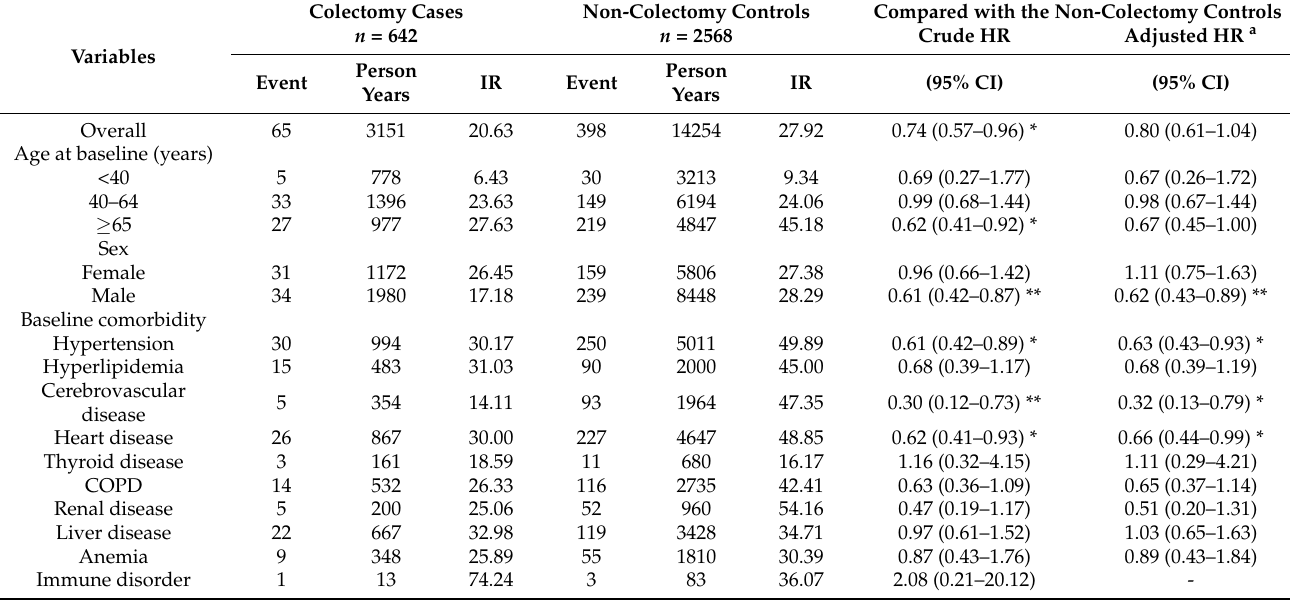
Table 3. Incidence rates and risk of type 2 diabetes in colectomy and non-colectomy patients without colorectal cancer.